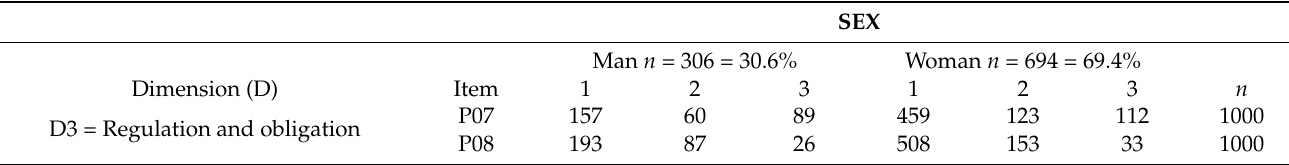
Table 3. Sex count of the participating sample for dimension D3.